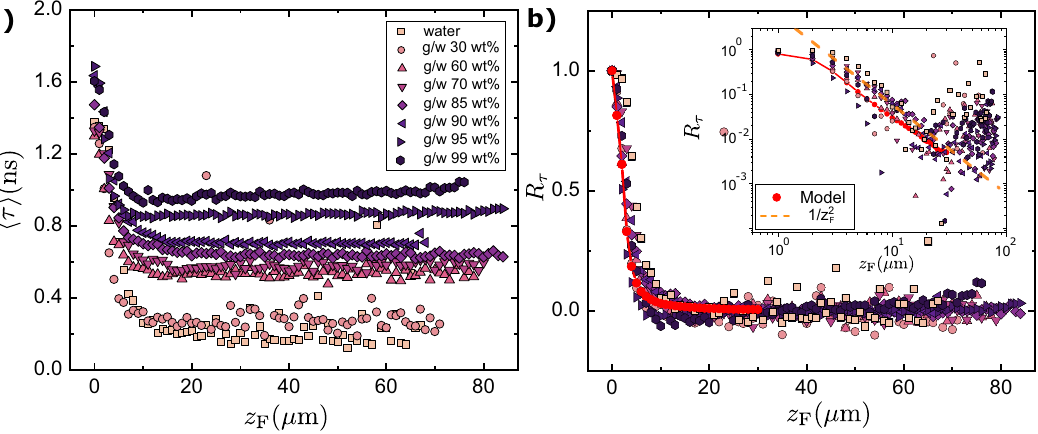
Figure 2. Data collapse of the fluorescence lifetime vs. depth of focus Fluorescence lifetime vs. nominal depth of focus into the solution ( i.e. as shown by the microscope stand), z F , from the hydrophobic glass at z F = 0 . ( a ) Amplitude averaged lifetime as a function of z F for various glycerol/water solutions; ( b ) Empirical data collapse R z F ) = ( � τ � ( z F ) − τ B )/( � τ � ( 0 ) − τ B ) . Red curve: normalized distribution function R th , Eq. (10), computed τ ( by ray tracing simulation from the basic parameters of the microscope and the refractive index of the samples. Inset: Same data, showing the 1 / z 2 F decay of the interface